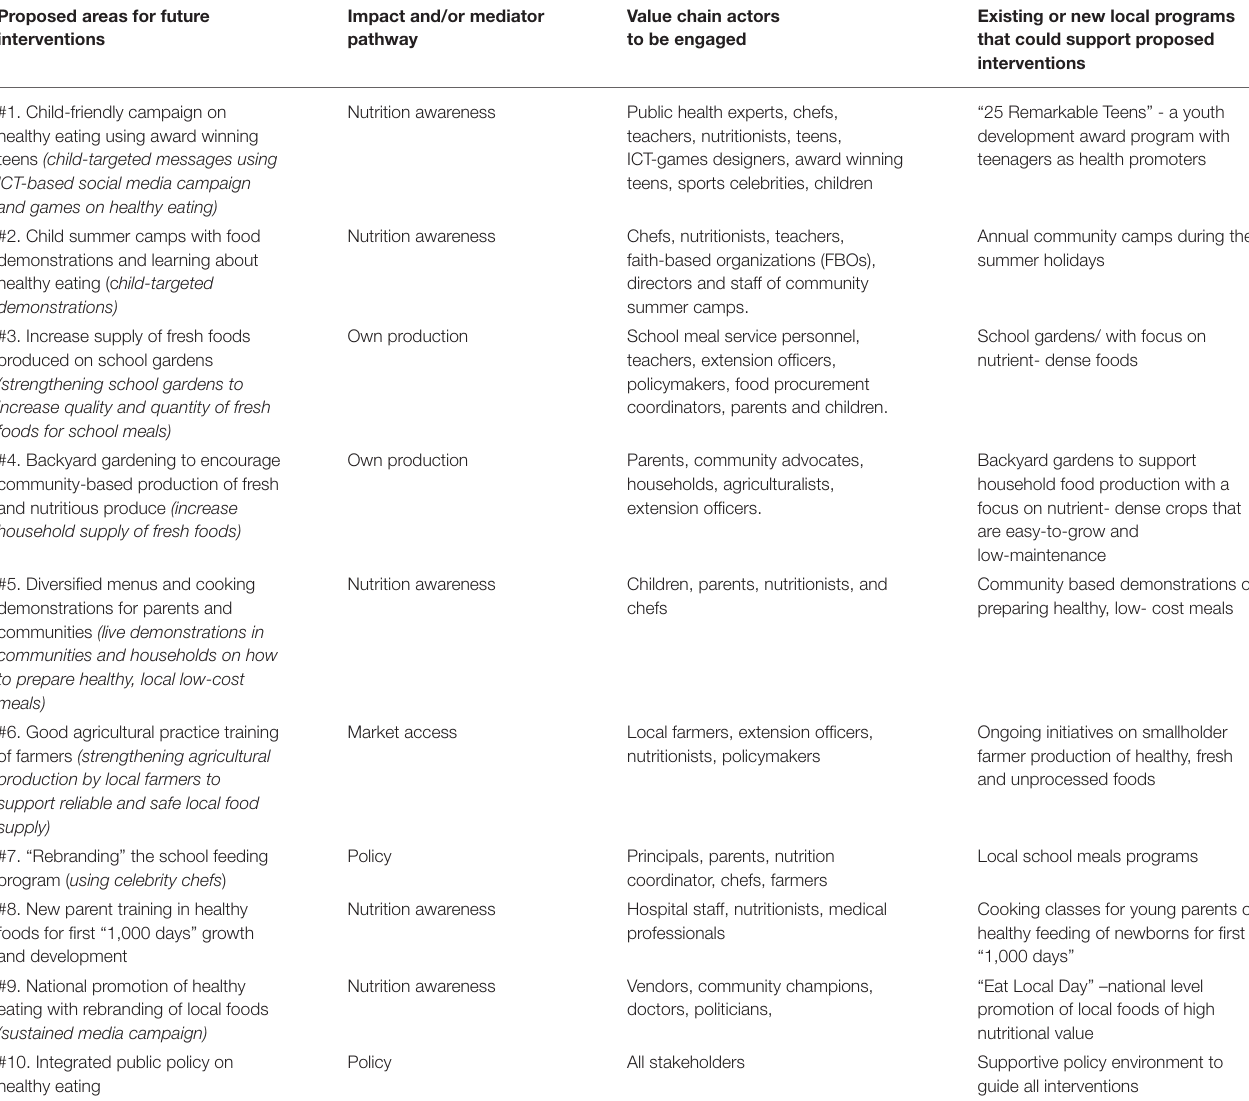
TABLE 2 | Interventions identified by workshop stakeholders showing links to existing local programs and the relevant value chain